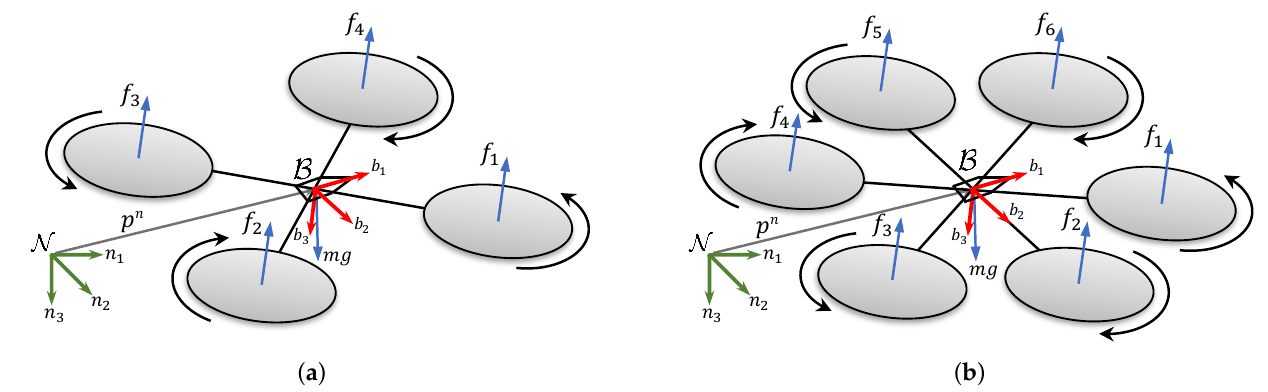
Figure 7. Schematics of ( a ) quadcopter and ( b ) hexacopter